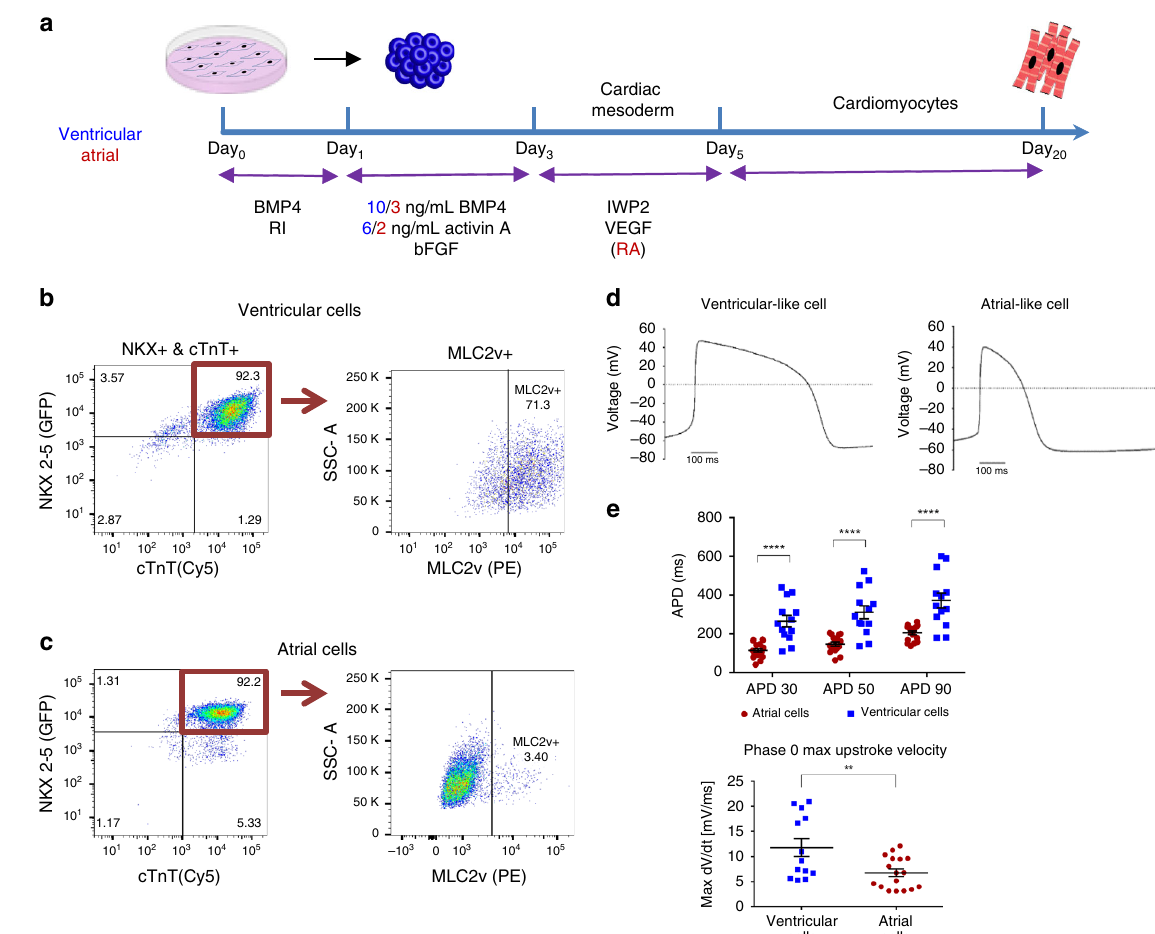
Fig. 1 Differentiation and characterization of the human embryonic stem cells derived ventricular and atrial cardiomyocytes. a Schematic representation of the human embryonic stem cells (hESC) differentiation protocols used to derive ventricular (blue) or atrial (red) cardiomyocytes. b , c Representative fl ow-cytometric analyses of the proportion of NKX2.5 + /cTnT + cells (left panels) and the proportion of MLC2V + cells among these NKX2.5 + /cTnT + cells (right panels) in day 20 HES3-NKX2 – 5 gfp/w EBs using either the ventricular ( b ) or the atrial ( c ) differentiation protocols. Note that using the ventricular and atrial differentiation protocols ~1% and ~5% of the differentiating cells, respectively, were TnT + /Nkx2.5 − cells (sinoatrial node like cells) and that among the differentiating cTnT + /NKX2.5 + cells obtained ~71% and ~3%, respectively, were MLC2v positive. d Patch – clamp action potential (AP) recordings of hESC-derived ventricular (left tracing) and atrial (right tracing) cells during 1 Hz fi eld stimulation. e Summary of AP duration (APD) measurements from hESC-derived ventricular (blue) and atrial (red) cells (values are expressed as mean ± SEM). Note that hESC-derived atrial cardiomyocytes ( n = 17, biologically independent cells) displayed shorter APD 30 , APD 50 , and APD 90 values and decreased phase 0 maximal upstroke velocity compared with the ventricular cells ( n = 13, biologically independent cells). Recordings were performed at 1 Hz stimulation frequency of. ** p < 0.01, **** p < 0.0001, unpaired t test is used for